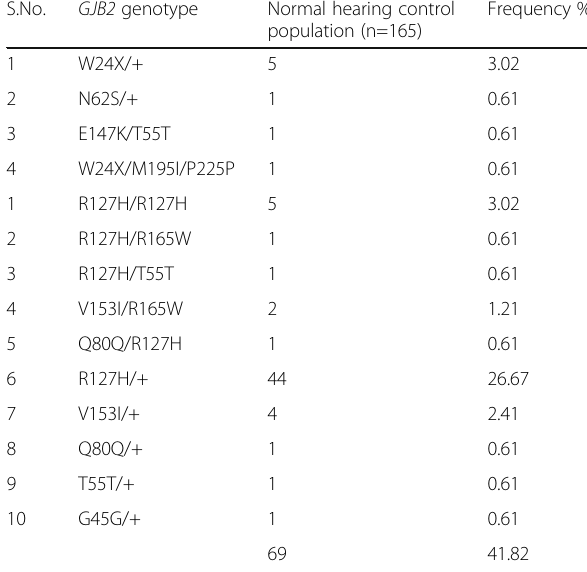
Table 10 Frequency and distribution of GJB2 genotypes observed among the 165 normal hearing controls